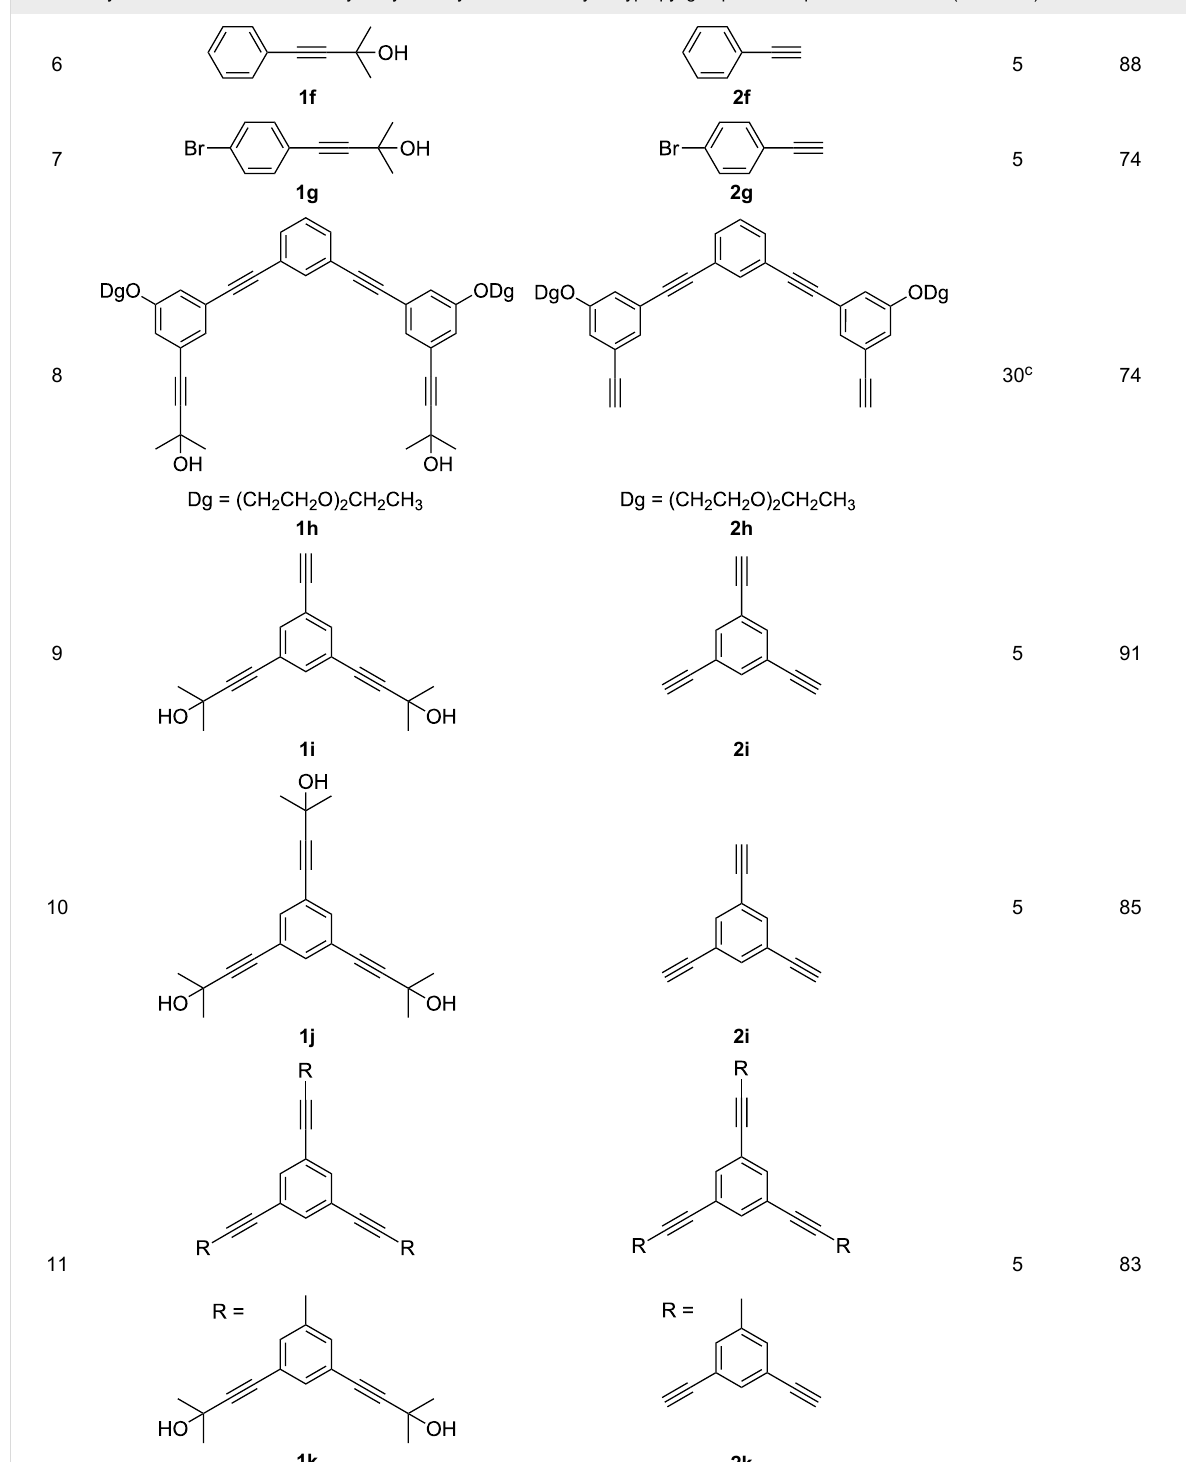
Table 3: Synthesis of different terminal arylacetylenes by removal of 2-hydroxypropyl groups under optimal conditions a . (continued)